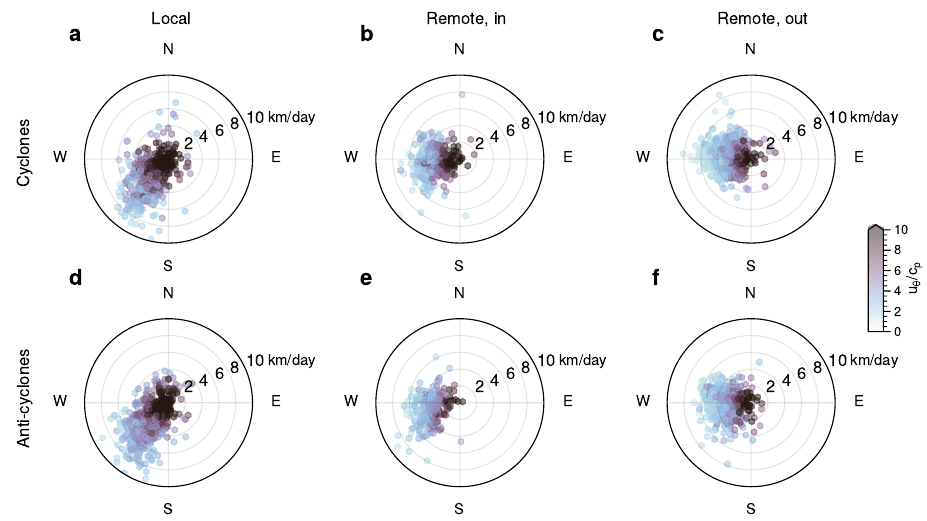
Figure 9. Scatter plots of eddy propagation speed colored by the nonlinear parameter ( u θ / c p ) of unique compact eddies in the South Brazil Bight. Upper panels ( a – c ) show cyclones and lower panels ( d – f ) anticyclones. As in Figure 8, the left panels ( a , d ) show local Brazil Current eddies, generated west of the black dashed line in Figure 7, the middle panels ( b , e ) show remote eddies that eventually propagated into the Brazil Current region, and the right panels ( c , f ) remote eddies that were never observed west of the black dashed line in Figure